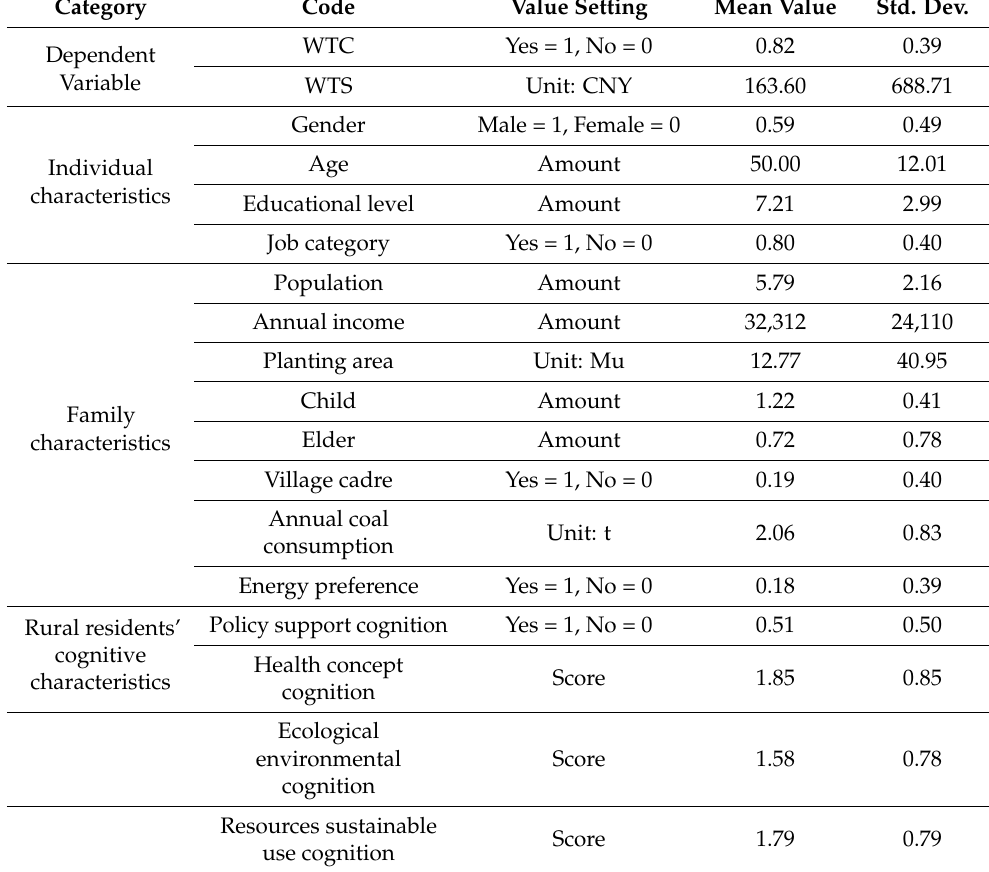
Table 2. Descriptive statistics for